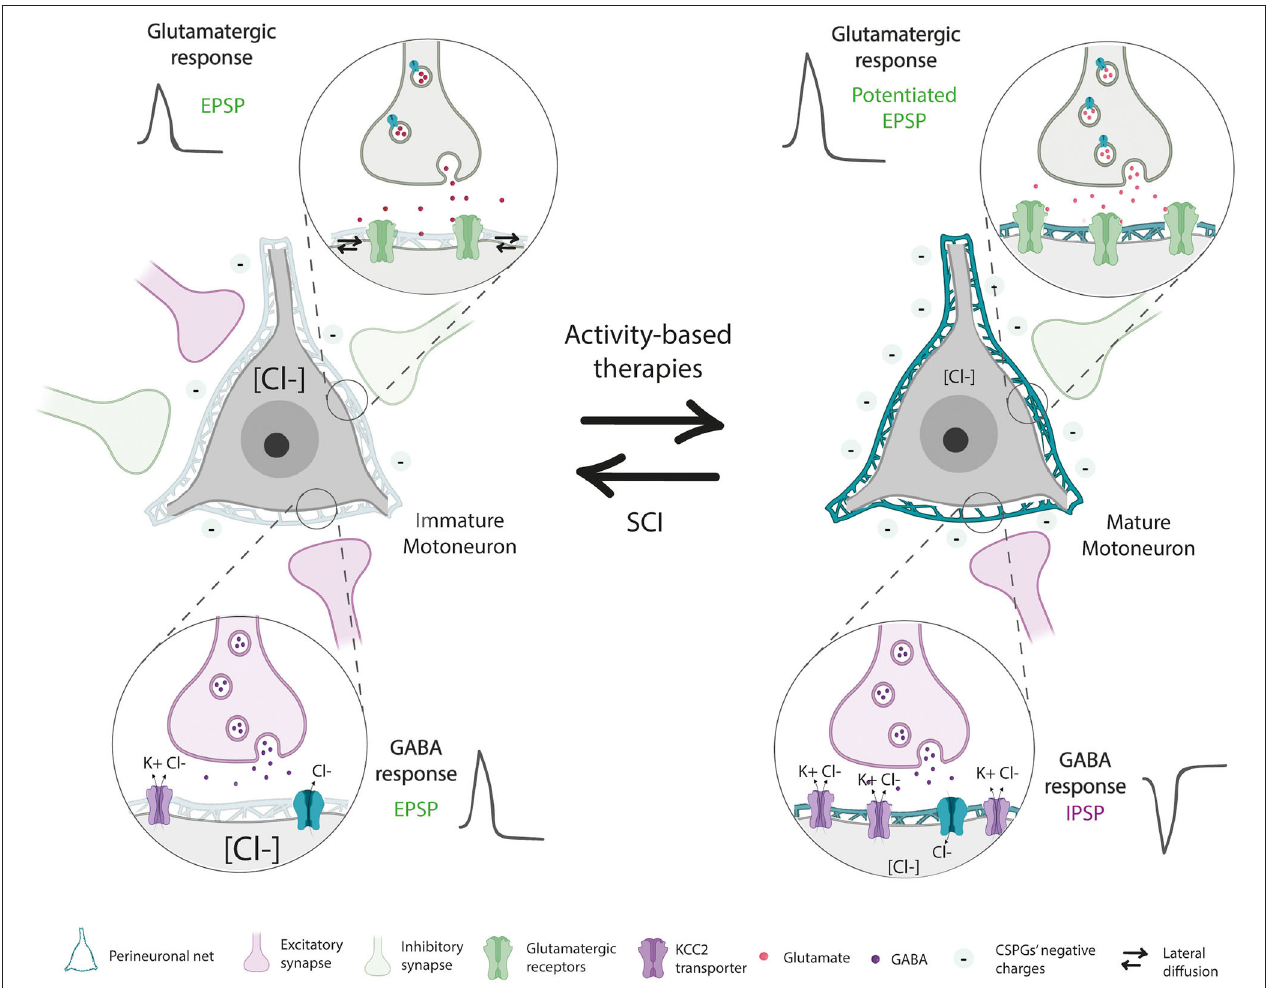
FIGURE 4 | Developmentally immature neurons and denervated neurons post-spinal cord injury (SCI) share similarities in PNN integrity and neuronal properties. Mature neurons present stable PNN, which generates a high density of negative charges around neurons that maintain ionic homeostasis necessary for proper synapse functioning. Besides, the physical barrier provided by PNNs maintains receptors in the cell surface and stabilizes synapses. However, after SCI, denervated neurons reduced PNNs thickness, shifting the GABAergic response of inhibitory neurons due to a reduction of the KCC2 co-transporter and a decrease of their negative chargers around the neuron. Besides, PNNs decline facilitates the mobility of receptors, generating inefficient excitatory synapses. These characteristics resemble those seen in developmentally immature neurons. The application of activity-dependent therapies prevents PNNs reduction and restores mature neuron